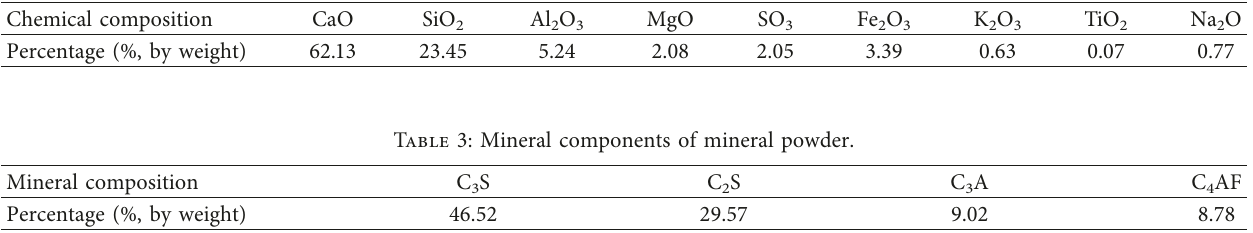
Table 2: Chemical components of P.O 42.5 cement.